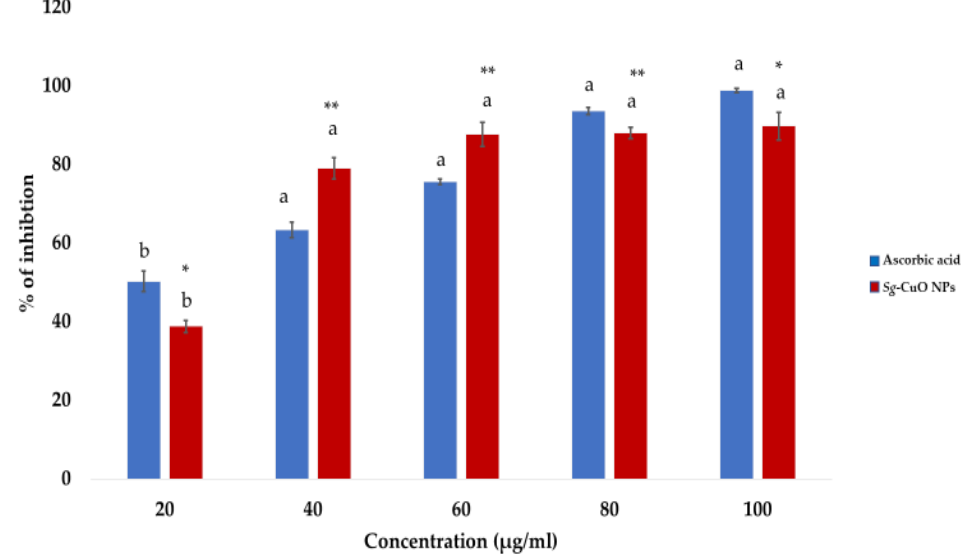
Figure 7. DPPH free radical scavenging activity of Sg -CuO NPs (20- 100 µ g/mL) plotted against the ascorbic acid (20–100 µ g/mL) (positive control). Values expressed in mean ± SD, ANOVA followed by Tukey’s post hoc, which showed a significant level p -value * < 0.001, ** < 0.05 (Lowercase let-